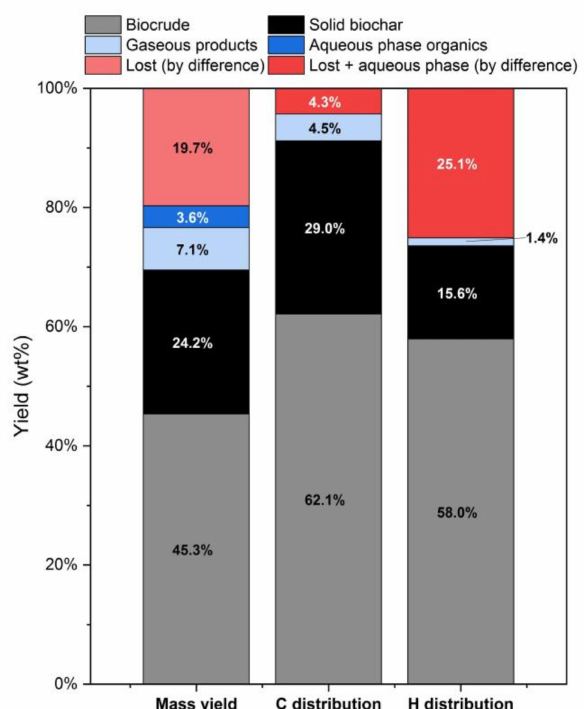
Figure 2. Mass yields of given product fractions, and respective C and H distributions in HTL bioproducts in the present